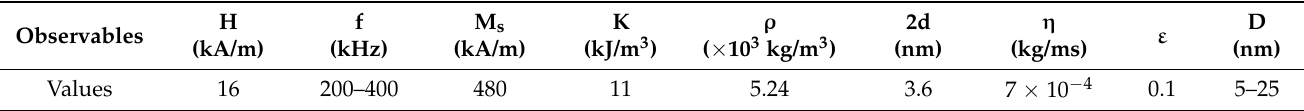
Table 1. The parameters of the alternating magnetic field and characteristic observables of Fe 3 O 4 -PAA– (HP- γ -CDs) nanoparticles; M s is the spontaneous magnetization of Fe 3 O 4 , K is the magnetocrystalline anisotropy constant of Fe 3 O 4 , ρ is the density of the nanoparticle material, d is the (mean) thickness of the organic shell (PAA–(HP- γ -CDs) on the surface of core Fe 3 O 4 nanoparticles, and η is the viscosity coefficient of the dispersion medium